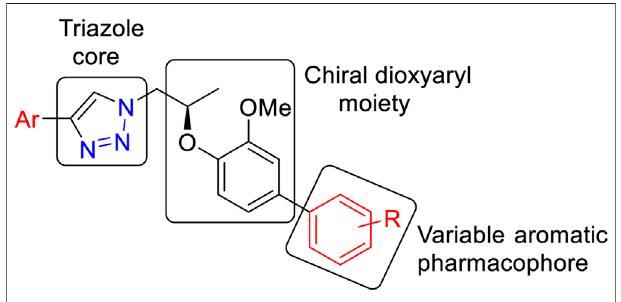
FIGURE 2 | General structural feature of the synthesized molecules ( 9